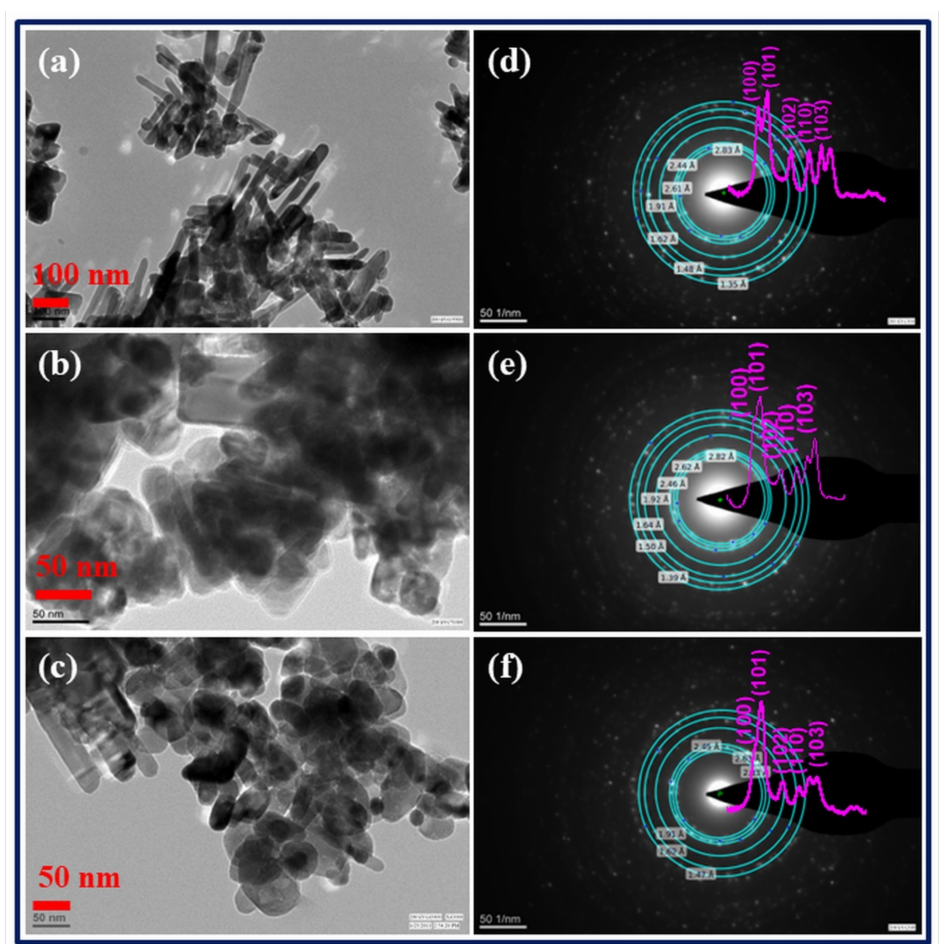
Figure 2. ( a – c ) TEM images of Zn 1 − x Li x O nanostructured samples ( a ) x = 0.00, ( b ) x = 0.03 and ( c ) x = 0.07. ( d – f ) SAED Pattern Zn 1 − x Li x O nanostructured samples, ( d ) x = 0.00, ( e ) x = 0.05 and ( f ) 0.07